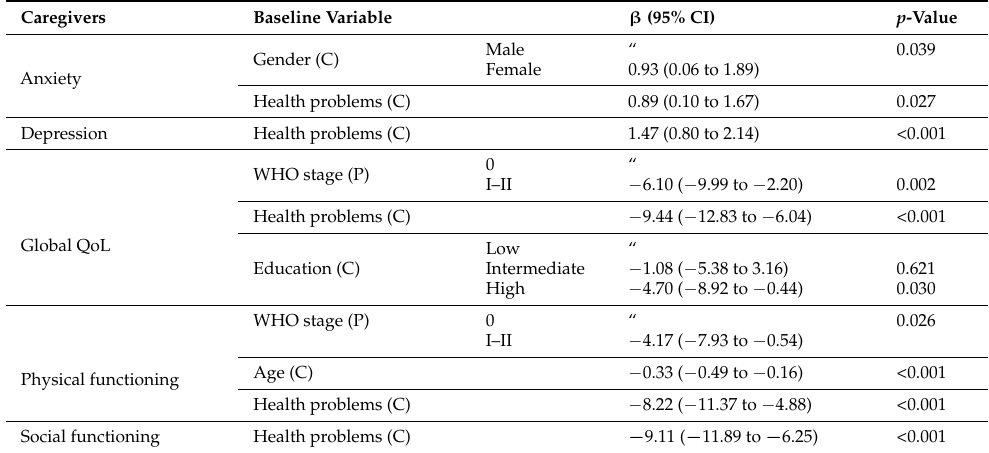
Table 4. Variables that were significant associated with psychological distress and reduced QoL in